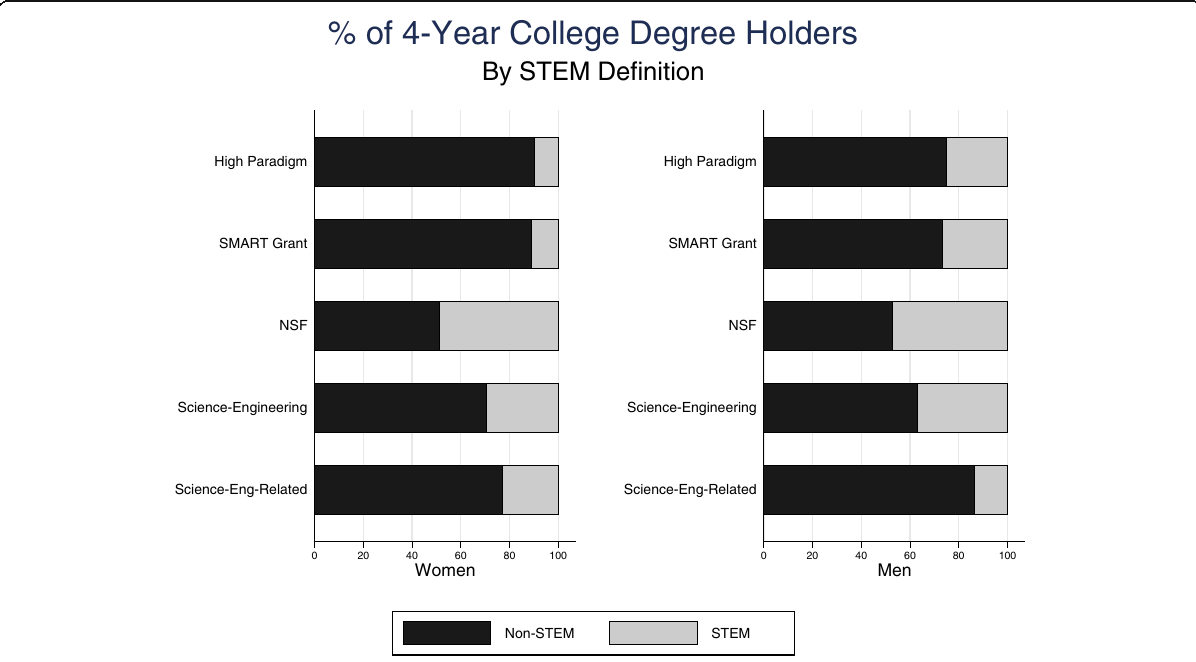
Fig. 1 Percent of 4-year college degree holders, by gender, for each definition of